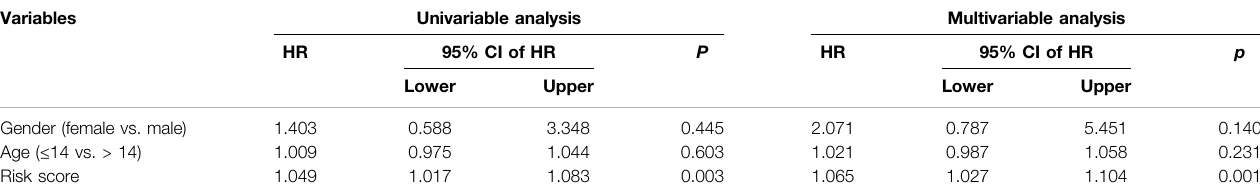
TABLE 3 | Univariable and multivariable analysis of the four-SLC prognostic signature and clinical factors in the GSE21257 cohort. Variables